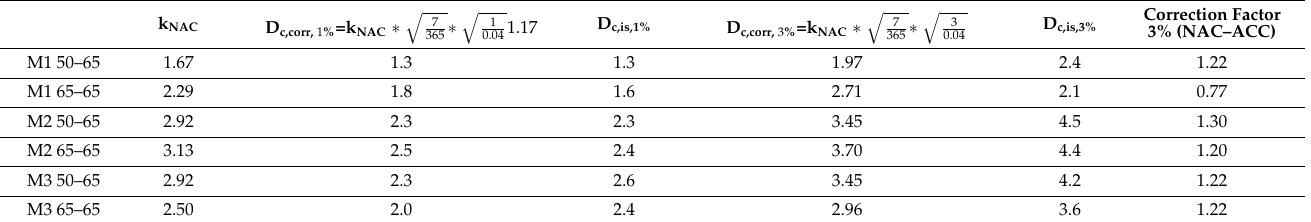
Table 8. Carbonation coefficient k NAC , theoretical and determined carbonation depth and correction factors for M1, M2 and M3 under different CO 2 exposure and varying pre-conditioning of either 50% or 65%